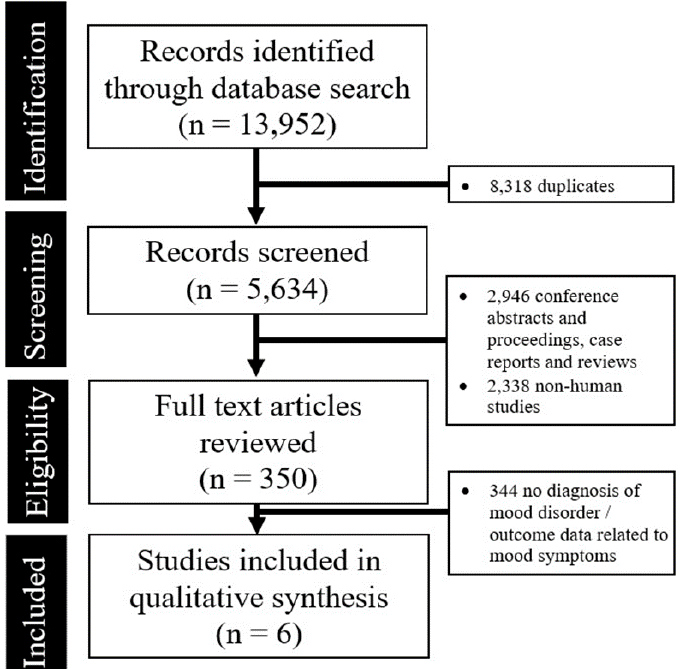
Figure 1. Preferred Reporting Items for Systematic Reviews and Meta-Analyses (PRISMA) flow diagram summarizing the studies identified during the literature search and the abstraction